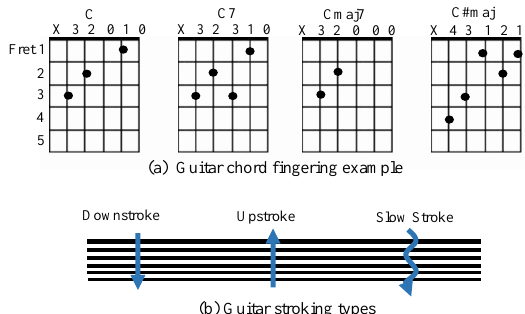
Figure 3. ( a ) Guitar fingering of the C chords. There are many forms of chords denoted by the same chord name ‘C’. The robot guitarist plays exhaustive combinations of different chord forms and strokes automatically, and the sounds are recorded as training samples. ( b ) Types of